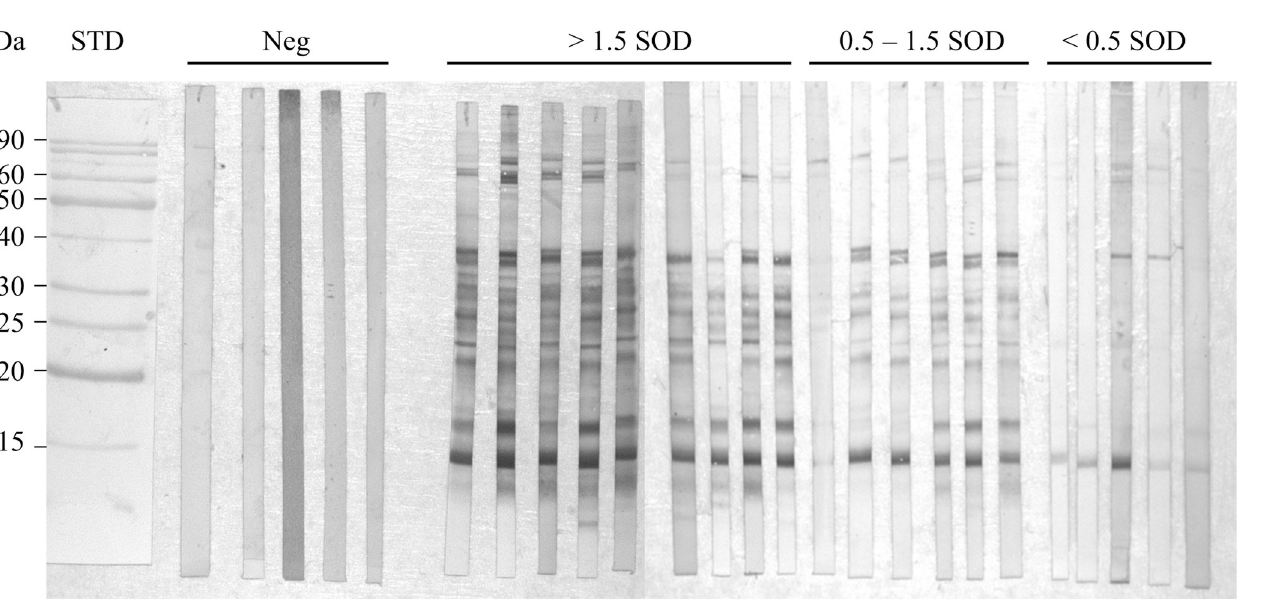
Fig 2. Immunoblot of salivary gland homogenate (SGH) of Simulium damnosum sensu lato . Five negative plasma samples from people living in Accra (Neg); nine plasma samples from people with an SOD value in the IgG ELISA greater than 1.5 ( > 1.5 SOD); six samples from people with an SOD value between 0.5 and 1.5 (0.5–1.5 SOD), and 5 samples from people with an SOD value lower than 0.5 ( < 0.5 SOD) were tested by western blot against SGH of S . damnosum s.l. STD: standard; SOD: Standardized Optical